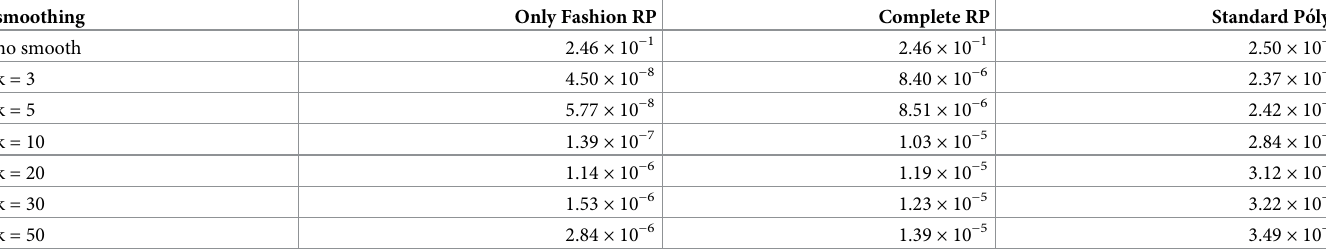
Table 22. “Covid” ( T = 0.5, entire, D = 3 0 , S = 100 slots of equal size): MSE for different levels of